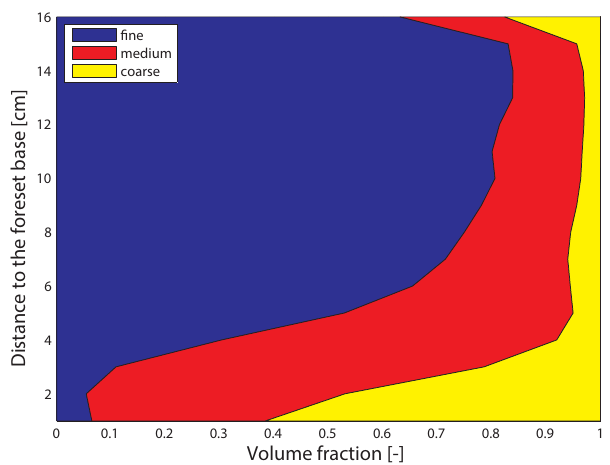
Figure 17. Vertical profile of the volume fraction contents for Ex- periment 2 (side sample) estimated through conversion of mea- sured areal fraction contents to volume fraction contents using the Parker (1991a, b) conversion